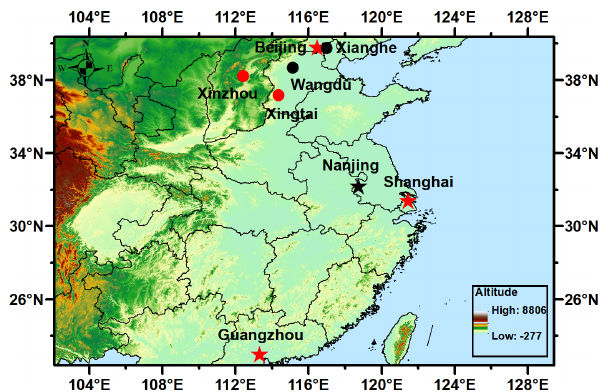
Figure 1. The map location of the sampling sites in this study (in red) and in previous studies (in black). The stars represent megac- ity sites and circles represent suburb sites. This map was made by ArcGIS (http://www.arcgis.com/index.html#, last access: 17 May